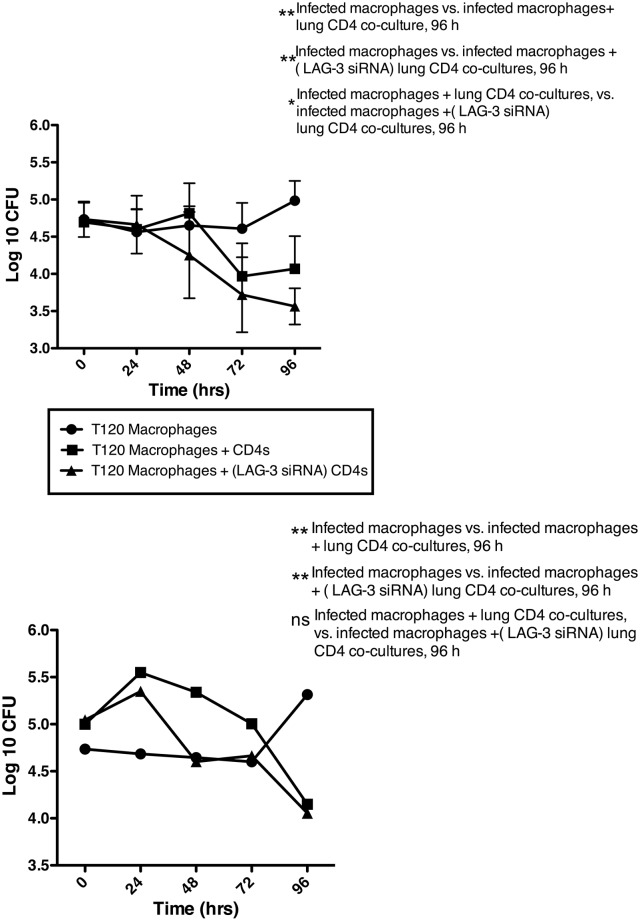
The effect of LAG-3 silencing on CD4+ T-cell killing of Mtb in a differentiated macrophage culture supplemented with CD4+ T-cells.Log10-bacterial burden at 0, 24, 48 72, and 96h post-infection in differentiated Mtb-infected macrophage cultures as well as co-cultures supplemented with CD4+ T-cells from blood (A) or lung (B) of Mtb-infected animals. The CD4+ T-cells were either untreated, or were silenced for LAG-3 with siRNA. The macrophage only cultures are indicated by solid circles, macrophage cultures supplemented with CD4+ T-cells are represented by solid squares, and macrophage cultures supplemented with LAG-3 silenced CD4+ T-cells are represented by solid triangles. Statistical significance was determined using a two-way ANOVA in Prism 6, with matched values stacked into sub columns, and using multiple comparisons to compare effects within each row (time) by comparing each experimental condition (macrophage, co-culture or LAG-3 RNAi co-culture) with every other condition at that time-point, with the Tukey multiple comparison test; the mean and SEM are represented by horizontal bars. *p < 0.05, **p < 0.01.